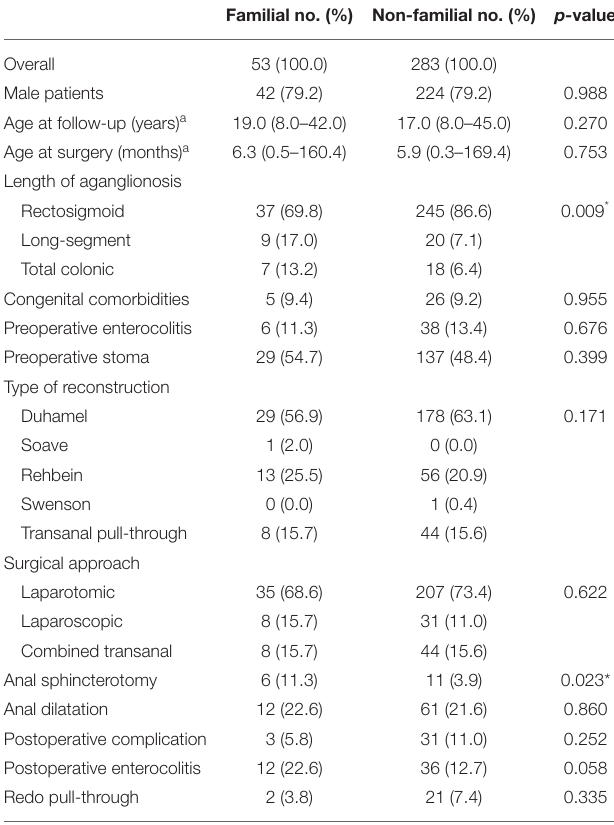
TABLE 1 | Characteristics of patients with familial vs. non-familial Hirschsprung’s